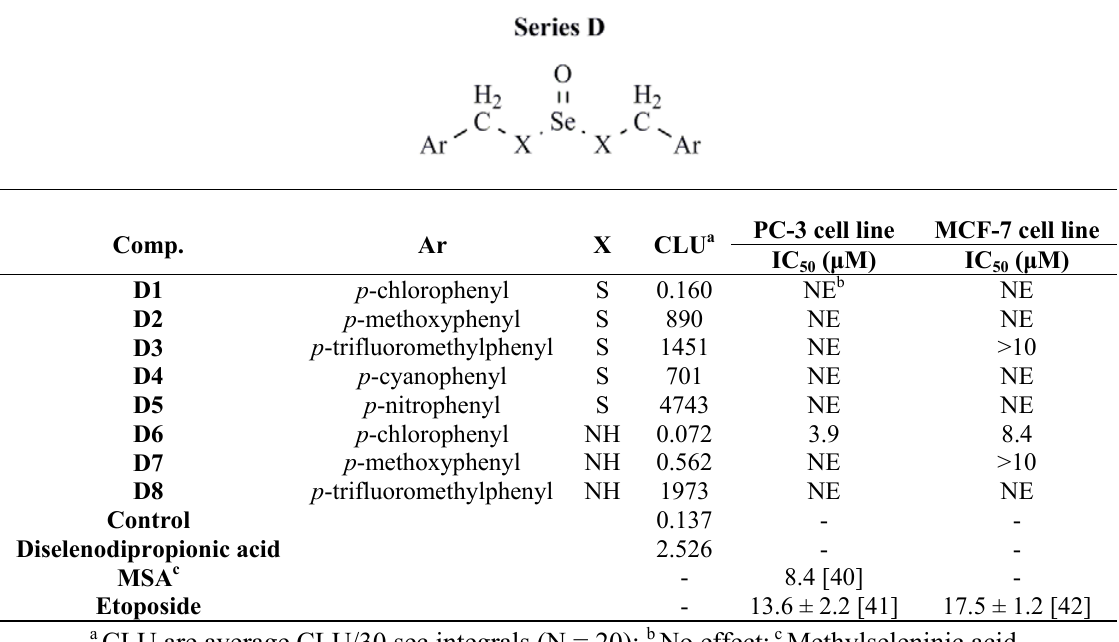
Table 4. Chemiluminescence (CLU) and cytotoxic activities (IC